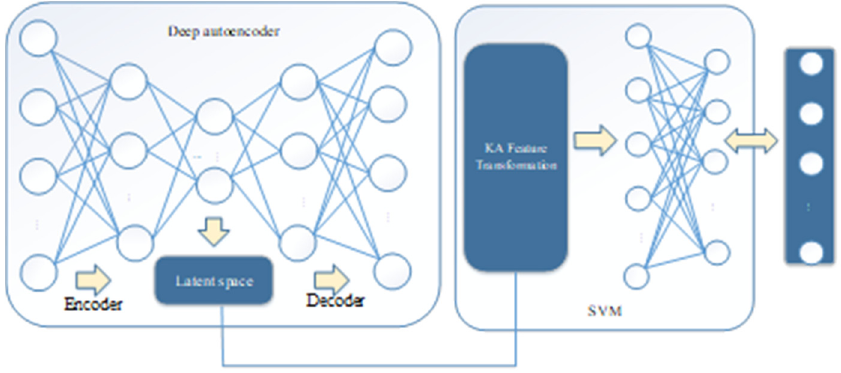
Figure 3. Proposed model framework. (KA denotes kernel approximation)